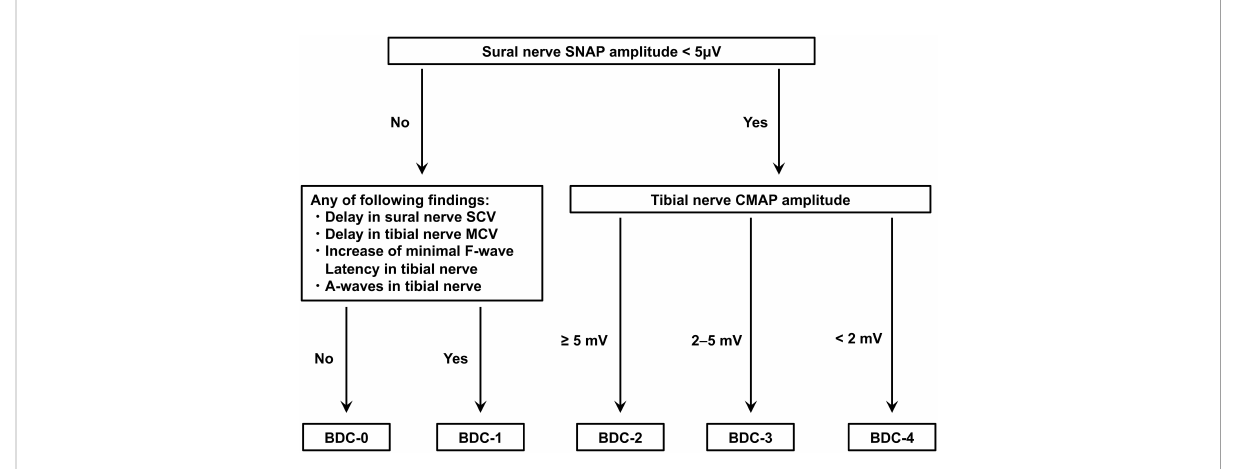
FIGURE 2 How to evaluate Baba ’ s diabetic classi fi cation by nerve conduction